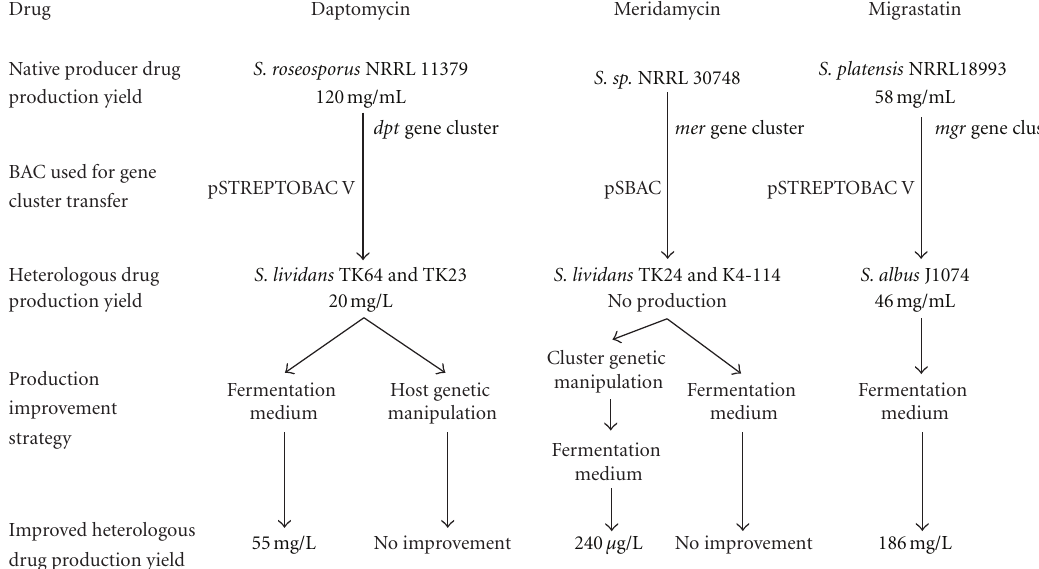
Figure 4: Strategies adopted to improve heterologous production of daptomycin, meridamycin, and migrastatin in heterologous hosts. Under “fermentation strategies” fall feeding with biosynthetic precursors or growth in presence of specific nutrients. Host genetic manipulation indicates the inactivation of host biosynthetic pathways or mutations in genes ( rpsL and rpoB ) known for increasing secondary metabolite production. Genetic cluster manipulation refers to the cloning of a strong promoter upstream of foreign genes which are weakly transcribed. Details are provided in the